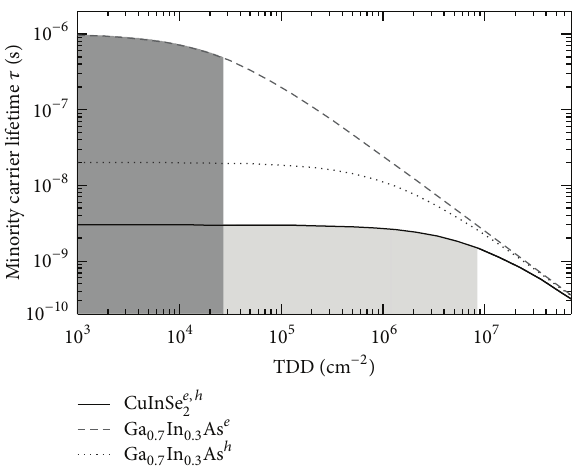
Figure 5: Minority carrier lifetimes in CuInSe 2 and GaInAs as a function of threading dislocation densities (TDD). A threshold density of 8.4 × 10 6 cm −2 for CuInSe 2 can be observed based on the reduction of the lifetime by a factor of 2 (marked by light gray rectangle), whereas the threshold is closer to 2.6 × 10 4 cm −2 for electrons in GaInAs (marked by dark gray